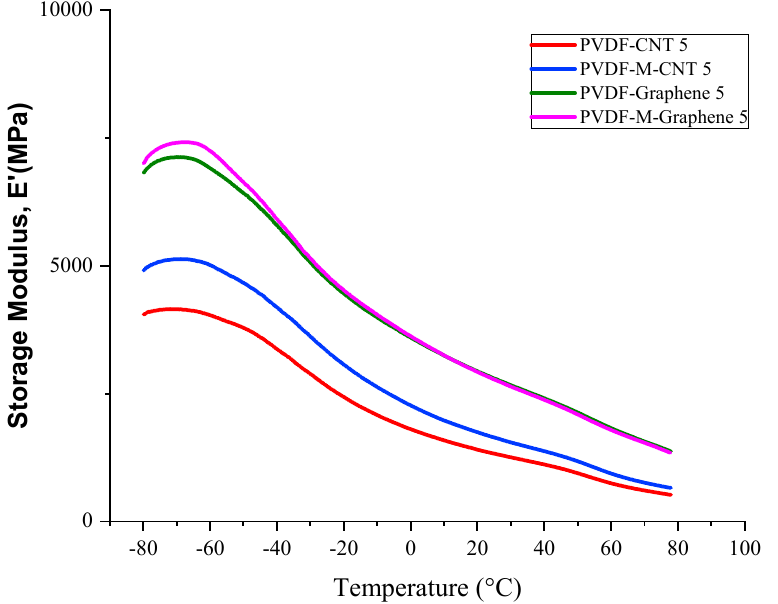
Figure 10. Storage modulus of the treated and untreated MWCNT/CNF-PVDF nanocomposites.